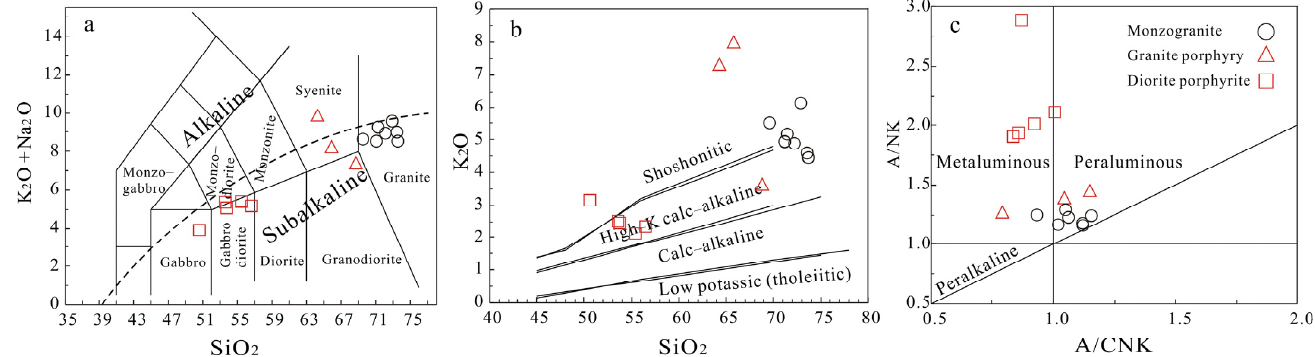
Figure 5. ( a ) SiO 2 –(Na 2 O + K 2 O); ( b ) SiO 2 –K 2 O; and ( c ) (A/NK)–(A/CNK) diagrams for